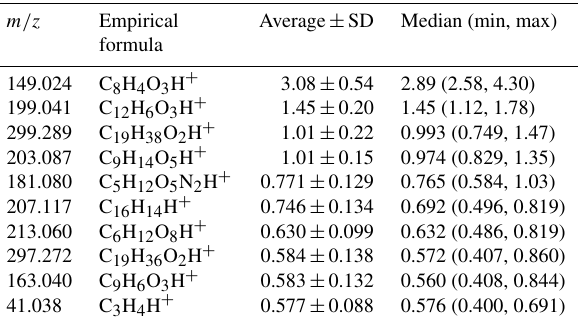
Table 5. The 10 highest EFs (mgkg − 1 of fuel) for